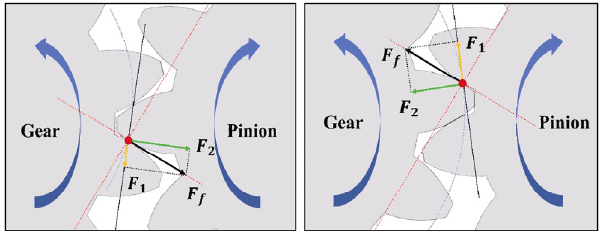
Fig. 4 Free-body diagram of the gear set (a) before and (b) after the pitch